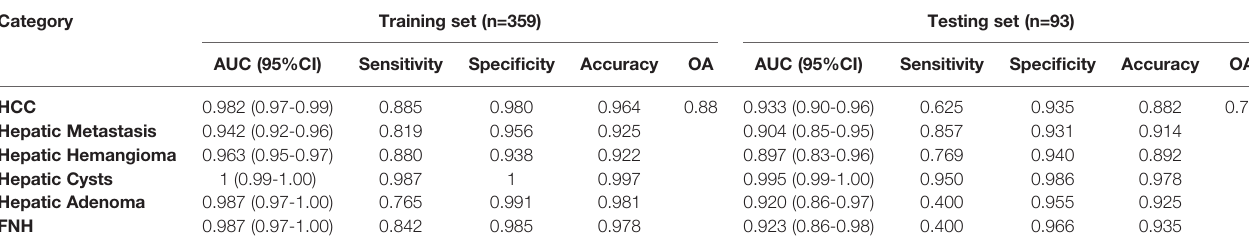
TABLE 2 | Diagnostic performance of radiomics models among six focal hepatic lesions based on unenhanced CT images. Category Training set (n=359)